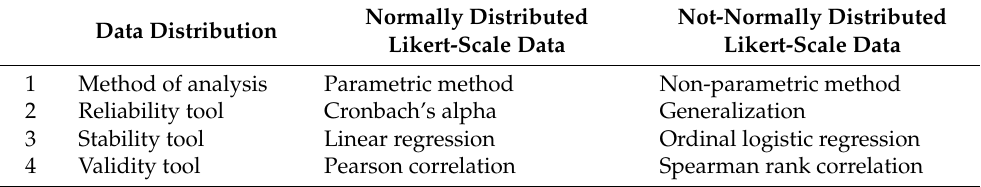
Table 5. Type of data